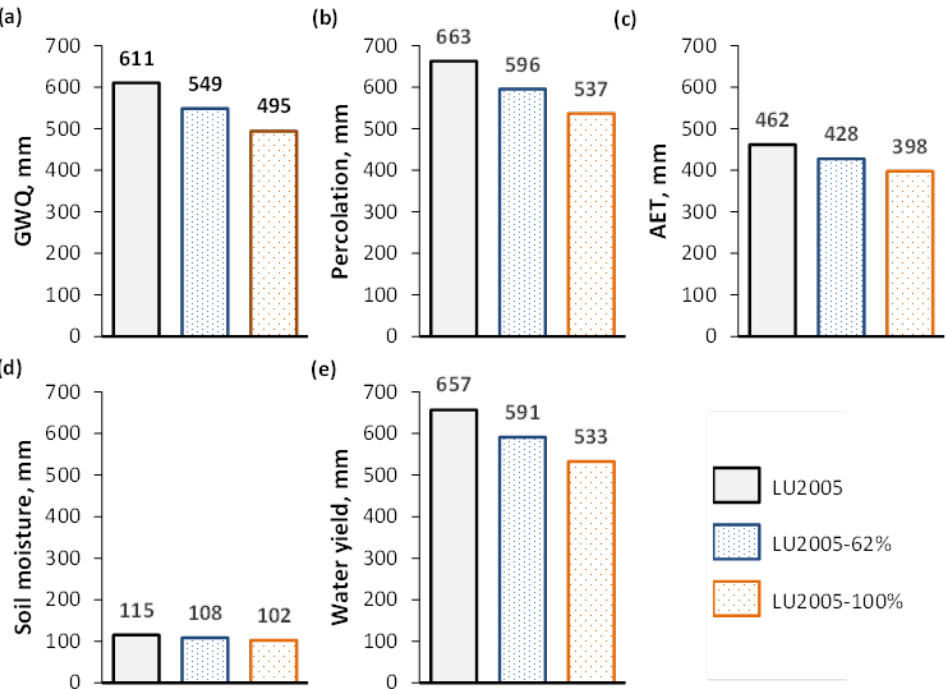
Figure 10. Water balance components: groundwater contribution to streamflow, GWQ ( a ), perco- lation ( b ), AET ( c ), soil moisture ( d ), and water yield ( e ) estimated for the observed land use pat- tern (LU2008) and under 62% (LU2008-62%) and 100% (LU2008-100%) afforestation scenarios in 2008, representing drought conditions.